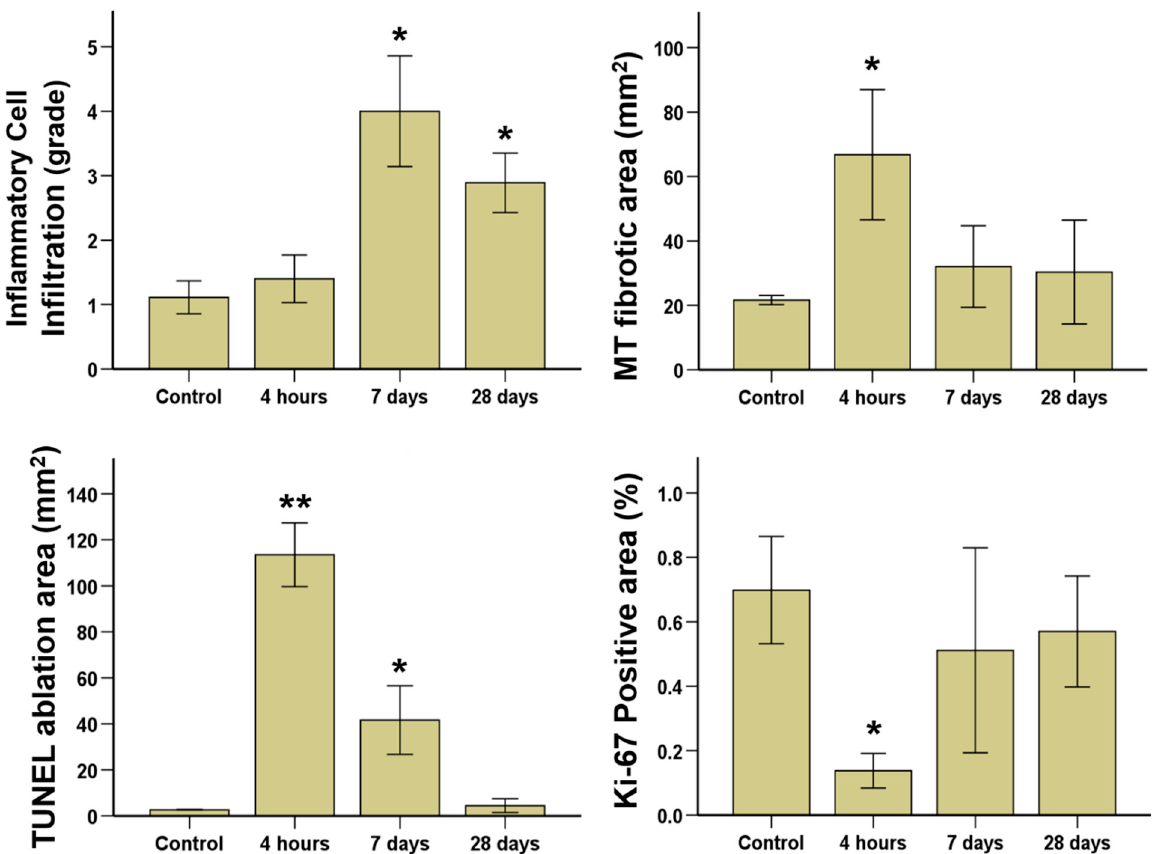
Figure 6. Histopathologic results of the control and treatment groups at different time points after irreversible electroporation with high-frequency pulsed electric field. * p < 0.05; ** p < 0.01, compared with control.